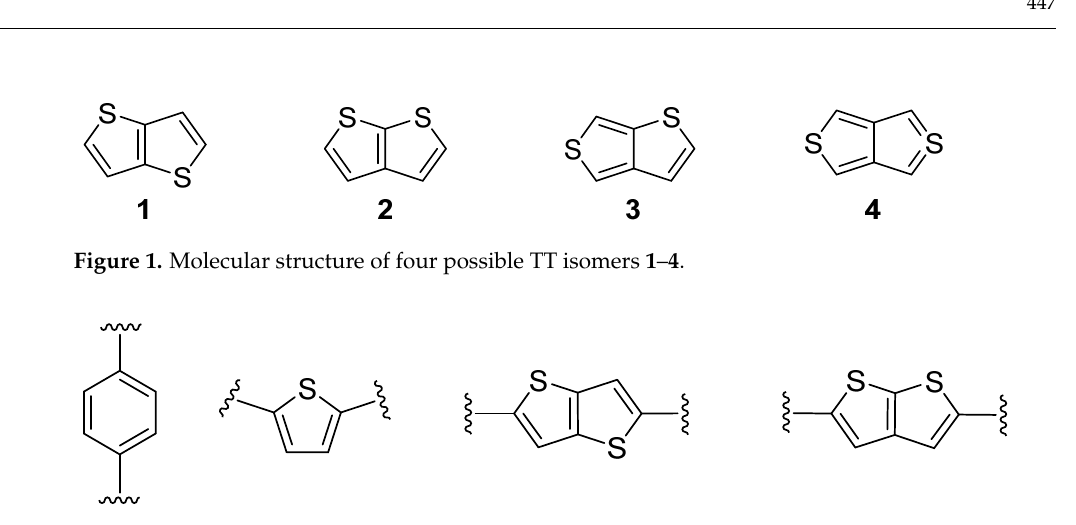
Figure 2. π -Linker examples commonly used in push–pull molecules.